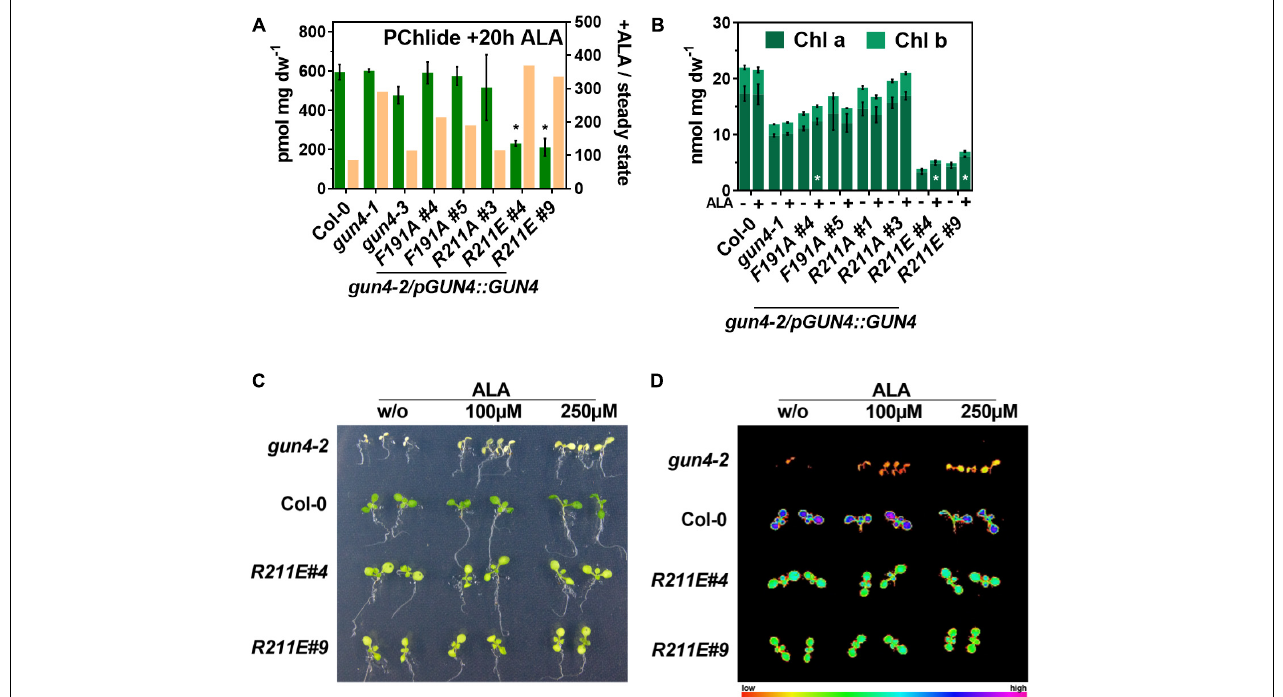
FIGURE 5 | Impact of short and long-term ALA feeding on protochlorophyllide (PChlide) and chlorophyll (Chl) accumulation in gun4 mutants. (A) PChlide content of 21 days old seedlings grown in short-day incubated in buffer containing 1 mM ALA for 20 h in darkness (green). The ocre bars indicate the change in PChlide content upon ALA feeding relative to the steady-state level in the light (ratio + ALA/steady-state, right Y-axis). (B) Chl a and b content in WT and mutant plants germinated and grown for 14 days in continuous light on MS plates without (–) or supplemented with 250 µ M ALA (+). Statistical significance (* p < 0.05) relative to the WT (in A) or the control condition without ALA (in B) was calculated using student’s t-test with n = 3 replicates. Values are given as the mean ± S.D. (C) Phenotype and (D) maximum Chl fluorescence (Fm) induced by a saturating light pulse after 20 min of dark incubation using a PAM-imager. Increased Chl contents in gun4-2 after ALA feeding are indicated by pale-green cotyledons and higher fluorescence of Chl molecules. Plants were grown on MS media with 1% sucrose without or supplemented with the indicated ALA concentrations in continuous dim-light for 8 days. For gun4-2 , seeds of a heterozygous plant were sown, and white GUN4 knockout mutants were selected for the analysis